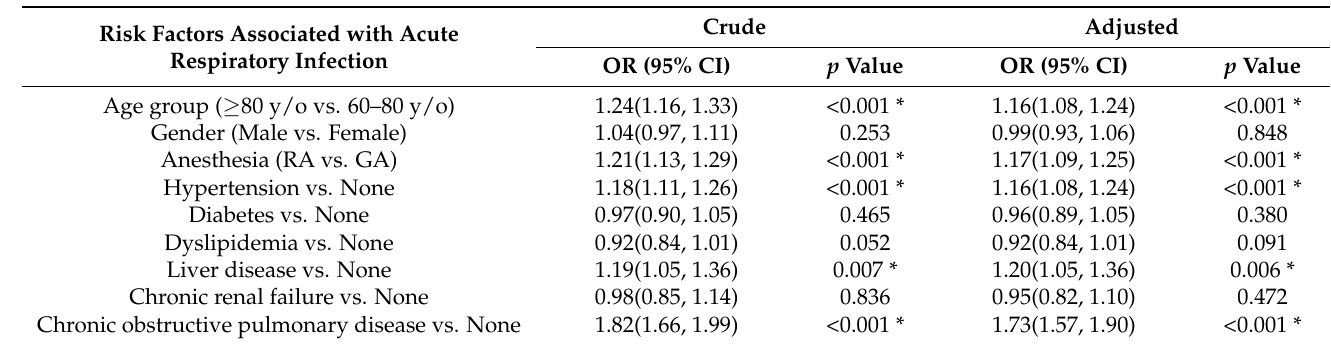
Table 2. Risk factors associated with the incidence of acute respiratory infection within postoperative 1 month ( n = 45,032).